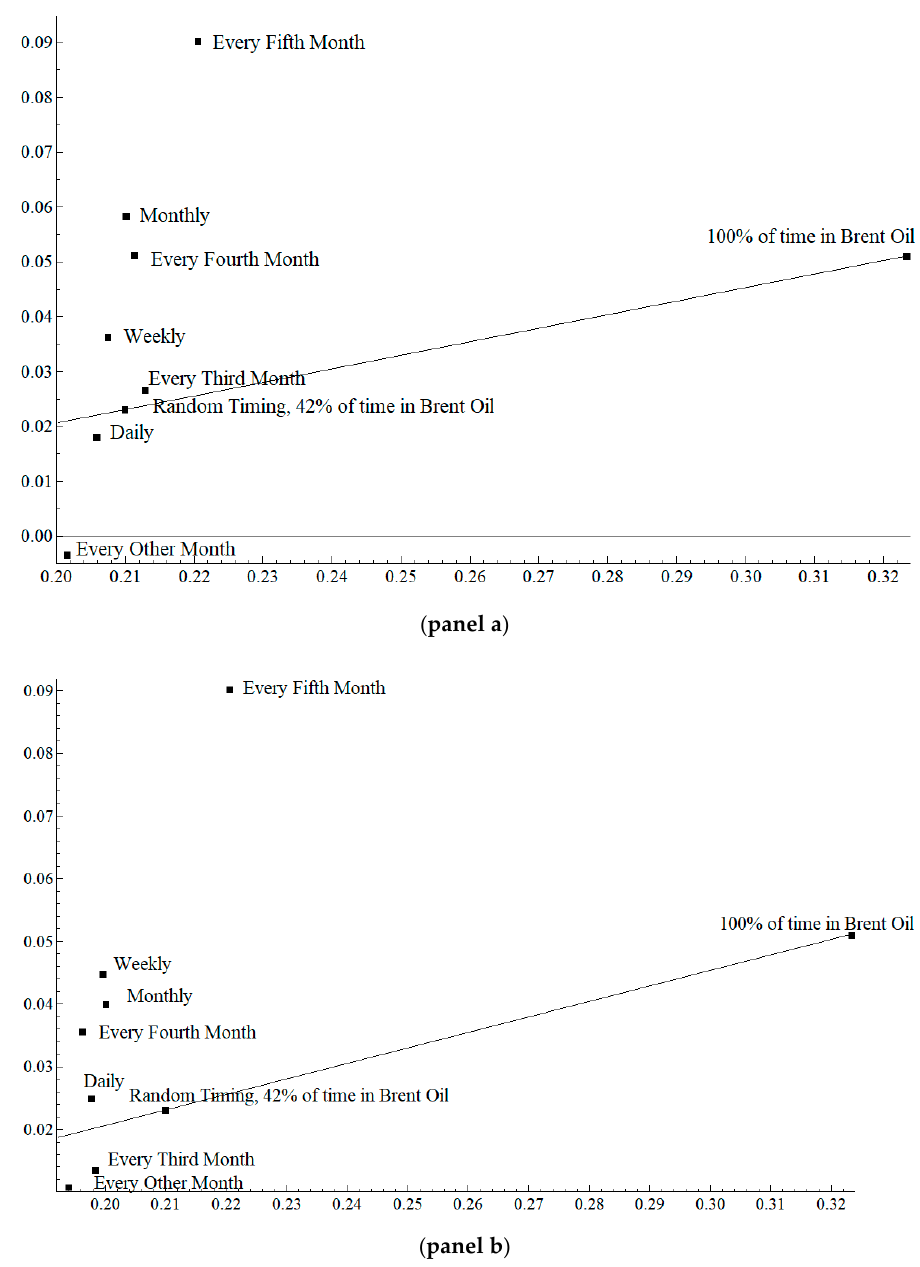
Figure 8. Returns to volatility ratios in Brent Oil Futures, 2 December 2008 to 28 September 2018, compared with random timing. ( panel a ) Calculated daily, weekly, monthly, every second month, every third month, every fourth month, and every fifth month; ( panel b ) Calculated with maximal rolling window, daily (MA200), weekly (MAW40), monthly (MA10), every second month (MAD5), every third month (MAT4), every fourth month (MAQ3), and every fifth month (MAC2).